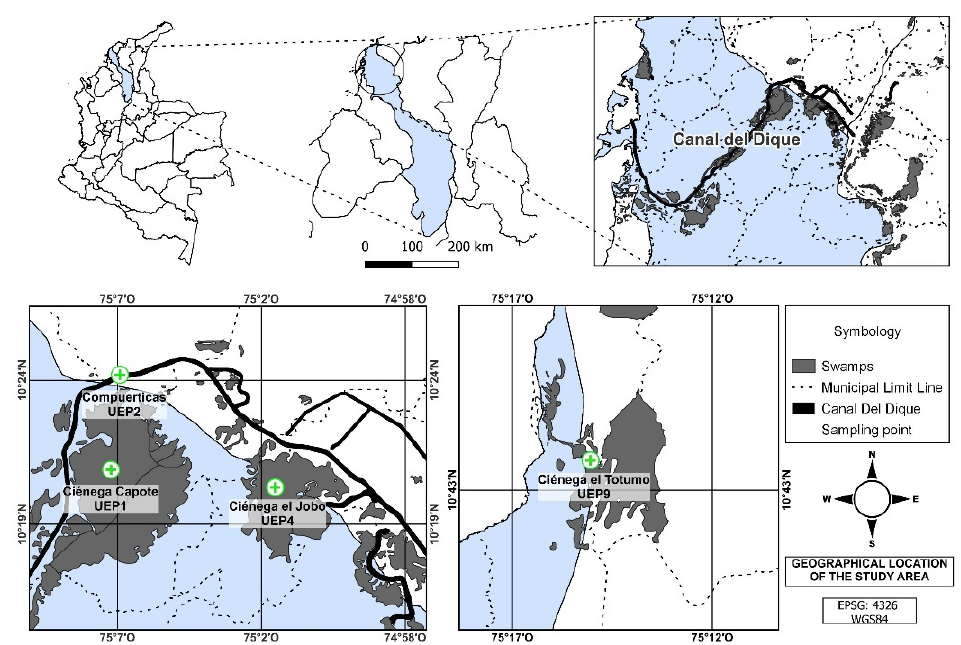
Figure 1. Map of the sampling points. Upper-right: Canal del Dique (sub-regions: UEP1: Capote Marsh, UEP2: Compuerticas UEP4: Jobo Marsh); and lower-left: Canal Norte (UEP9: Totumo Marsh).